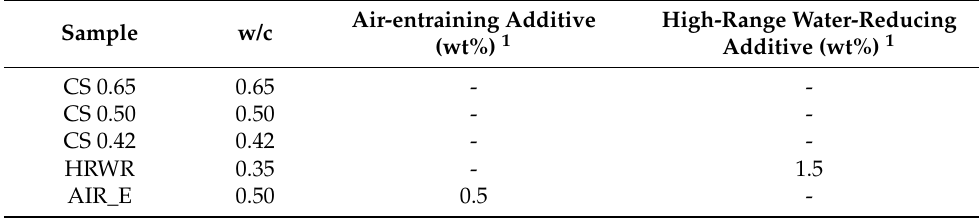
Table 1. Mix design of the investigated